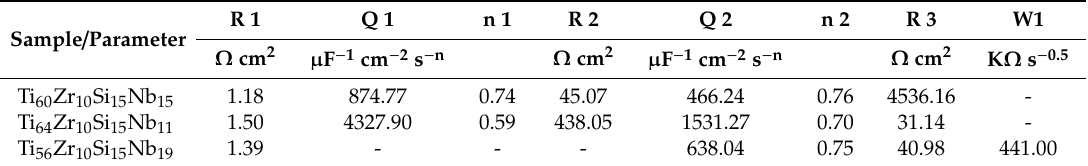
Table 6. Electrochemical impedance spectroscopy (EIS) results.